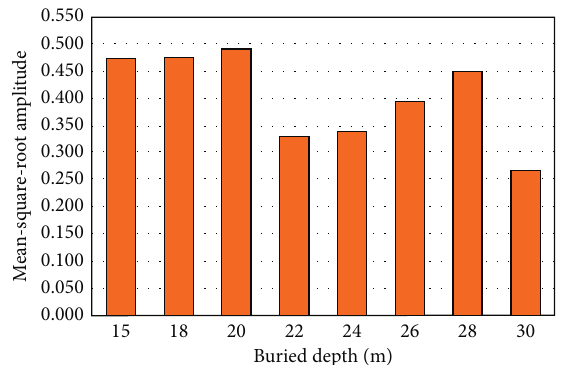
Figure 3: The energygram according to the seismic recorded obtained at different buried depths of the